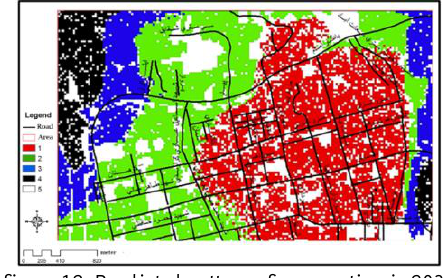
figure 12: Predicted pattern of segregation in